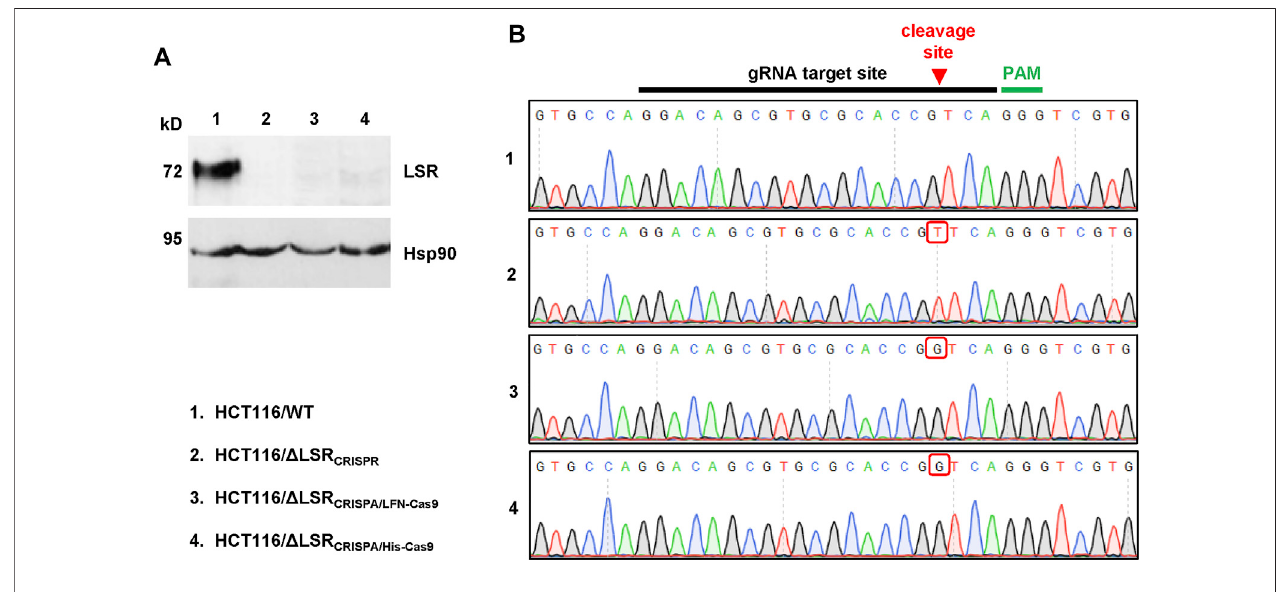
FIGURE3| Con fi rmationoftheCRISPA-mediatedLSRknockoutmutationinHCT116cells. (A) ImmunoblotforthedetectionofLSRandHsp90(loadingcontrol)in whole-cell lysates of wildtype and LSR-de fi cient HCT116 cells (a detailed description of the cells is provided in the legend of numbers within the fi gure) (B) Chromatograms obtained by Sanger sequencing are shown, comprising the gRNA target site, the Cas9 cleavage site (red arrow) and the PAM sequence with the LSR geneofwildtypeandLSR-de fi cientHCT116cells(adetaileddescriptionofthecellsisprovidedinthelegendofnumberswithinthe fi gure).Redboxpointstowardsa nucleotide insertion (mutation) that has been generated as a result of Cas9 cleavage and non-homologous end joining.